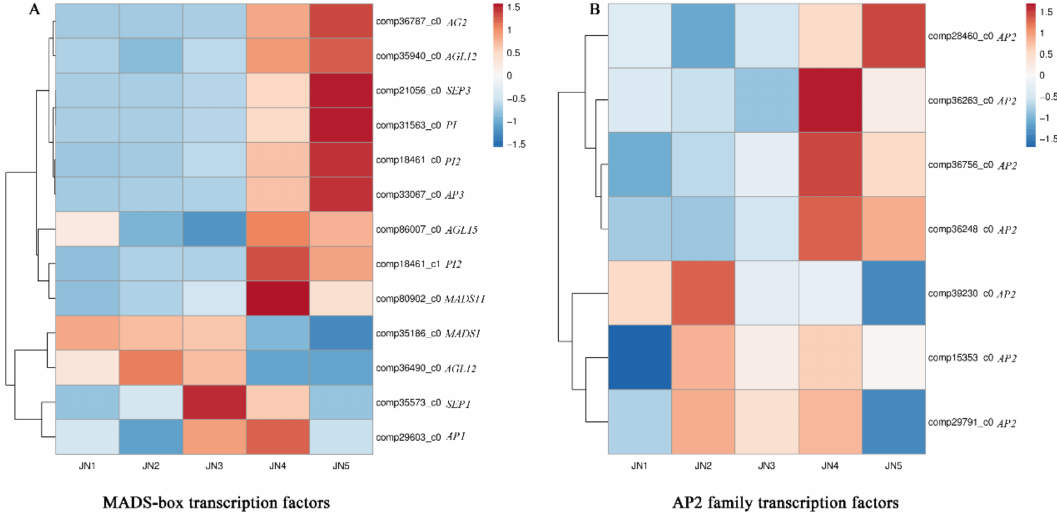
Figure 6. The expression of DEGs putatively encoding MADS-box and AP2 family transcription factors. ( A ) is the expression of DEGs putatively encoding MADS-box; ( B ) is the expression of DEGs putatively encoding AP2 family transcription factors. Comp indicates the prefix of the gene ID. Red and Blue represents up- and down-regulated DEGs,